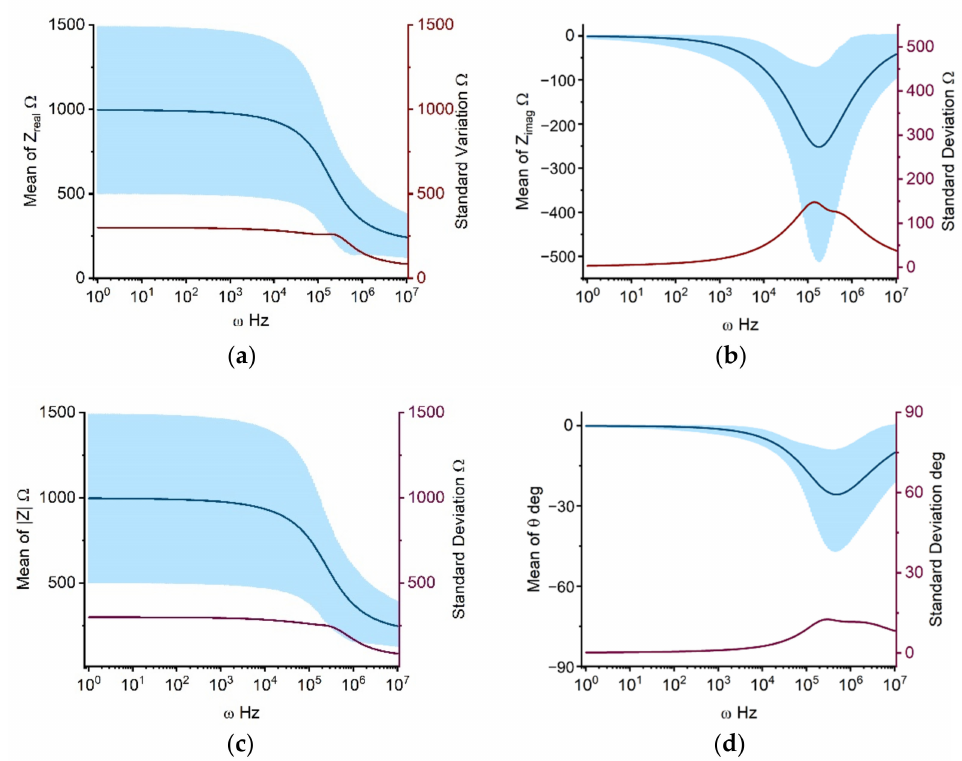
Figure 1. UQ quantifies the mean, standard deviation, and 90 percent prediction space of real ( a ), imaginary ( b ), magnitude ( c ), and phase ( d ) of the Cole impedance taking input uncertainties into account. The solid dark blue line depicts the mean value with frequencies ranging from 1 Hz to 10 MHz. The dark red line and light blue area represent the standard deviation and 90% prediction space,